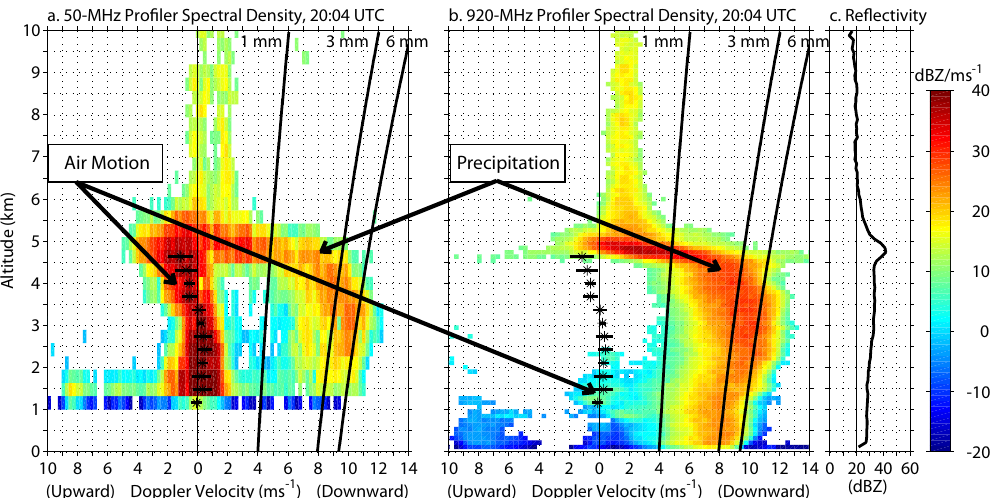
Fig. 4. Simultaneous vertical profiles of reflectivity-weighted Doppler velocity spectral density [units of dBZ (ms − 1 ) − 1 ] on 23 January 2006 at 20:04UTC for (a) the 50-MHz profiler and (b) the 920-MHz profiler. The ambient air motion is estimated from the Bragg scattering component in the 50-MHz profiler spectra (indicated in panel a). The first and second moments of the Bragg scattering component are indicated with asterisks and horizontal lines ( ω Dopper ± σ air ) on the 920-MHz profiler spectra in (b). The DSD is estimated from the Rayleigh scattering component of the 920-MHz profiler spectra shown in (b). The solid black lines labeled “1mm”, “3mm”, and “6mm” indicate the air density adjusted terminal fall speeds of raindrops with diameters of 1, 3, and 6mm,